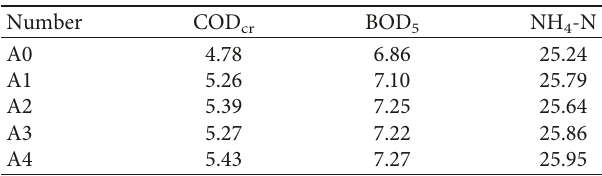
Table 10: Results of transport parameters of COD NH 4